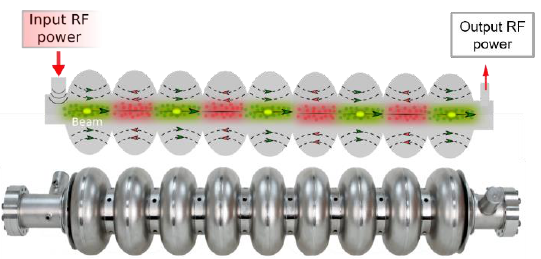
Figure 1. TESLA-shaped a 9-cell elliptical cavity made of Nb operating at 1.3 GHz [2].